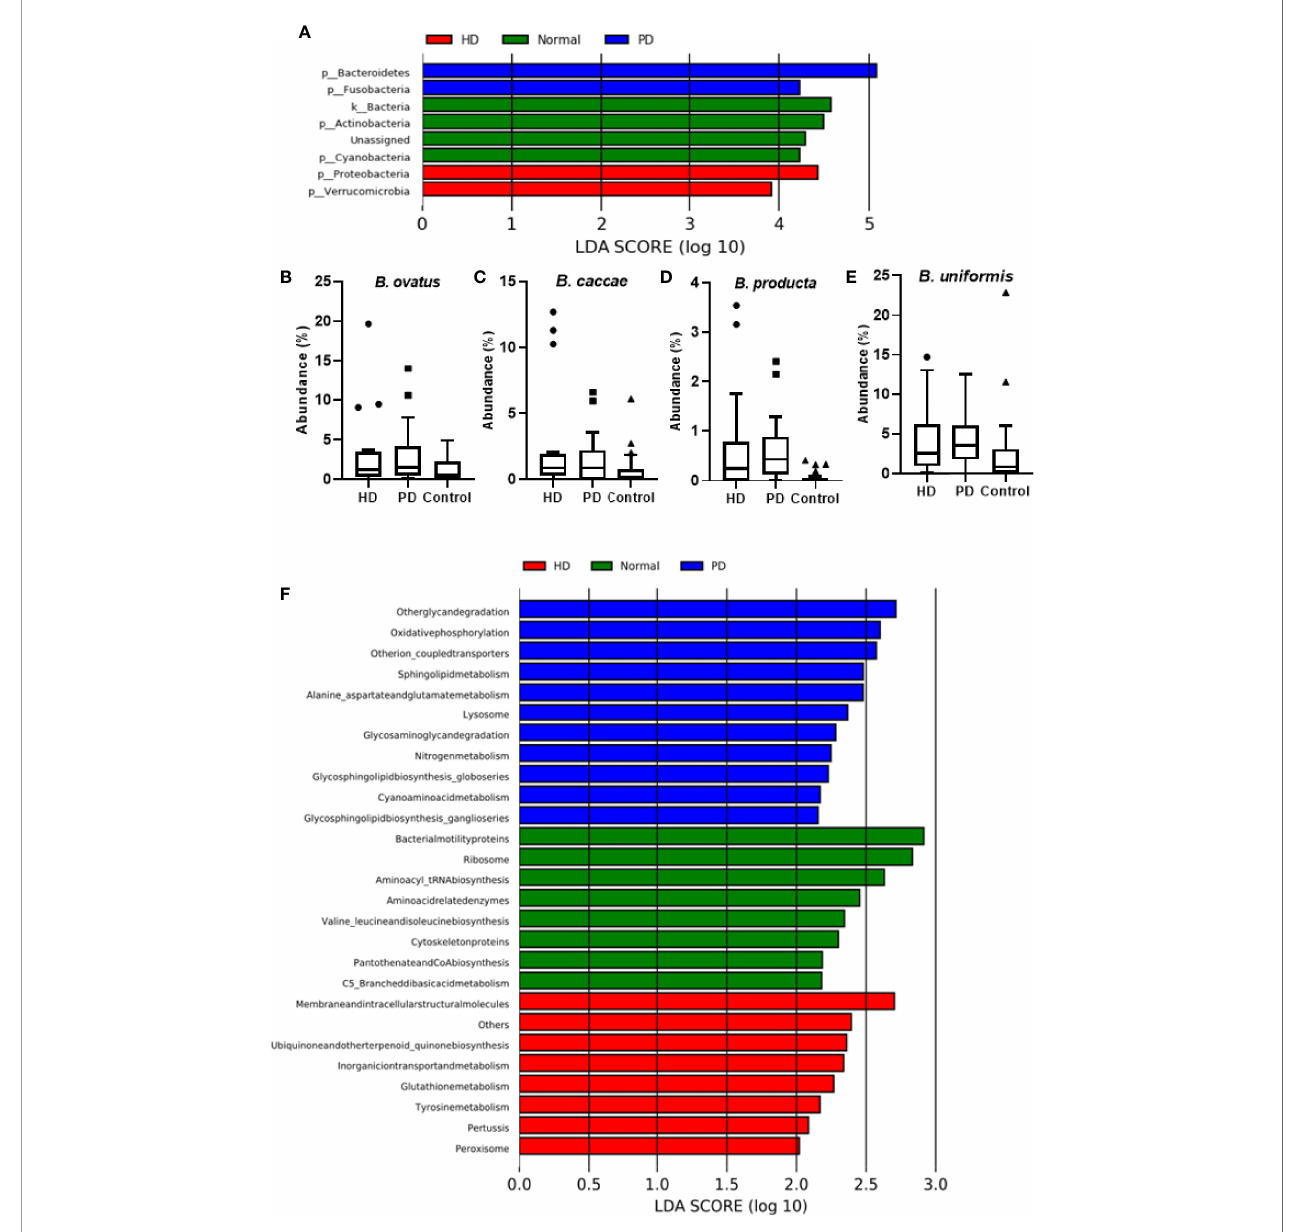
FIGURE 3 | Analysis of Bacterial Community in Dialysis Patients. (A) LEfSe analysis of bacterial taxa at the phylum level for HD, PD, and control groups. Average abundance percentage of identi fi ed bacterial species between the three groups for (B) B. ovatus , (C) B. caccae , (D) B. producta , and (E) B. uniformis . (F) PICRUSt analysis showing functional pro fi les of the microbial samples from different groups at Kyoto Encyclopedia of Genes and Genomes (KEGG) level